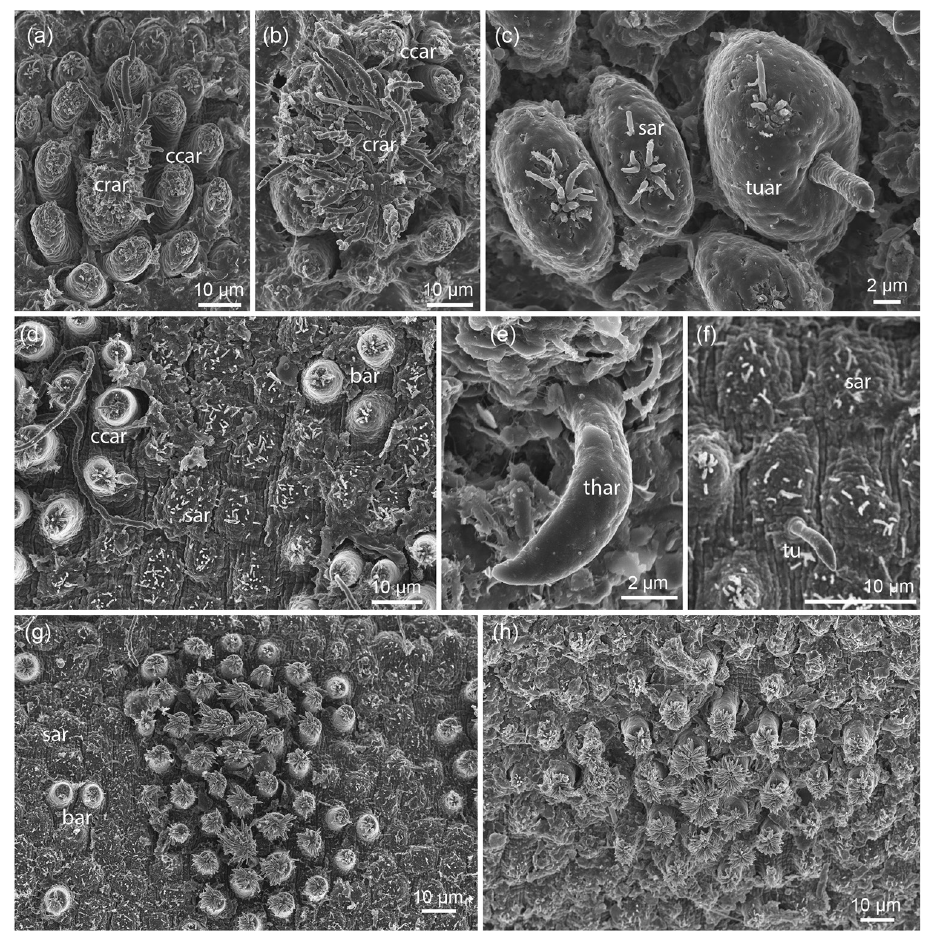
Figure 3. a–c Chordodes combiareolatus : a, b cluster of crowned areoles ( crar ) and circumcluster areoles ( ccar ) in different degrees of preservation of the apical filaments c simple areoles ( sar ) and the combined simple/tubercle areoles ( tar ) characteristic for this species d–h Chordode s cf. furnessi : d simple areoles ( sar ) and bulging areoles ( bar ) between clusters of crowned areoles ( ccar = circumcluster areoles) e thorn areole ( thar ) f tubercle ( tu ) g, h two different clusters of crowned and circumcluster areoles, where no differences between these two types of areoles are